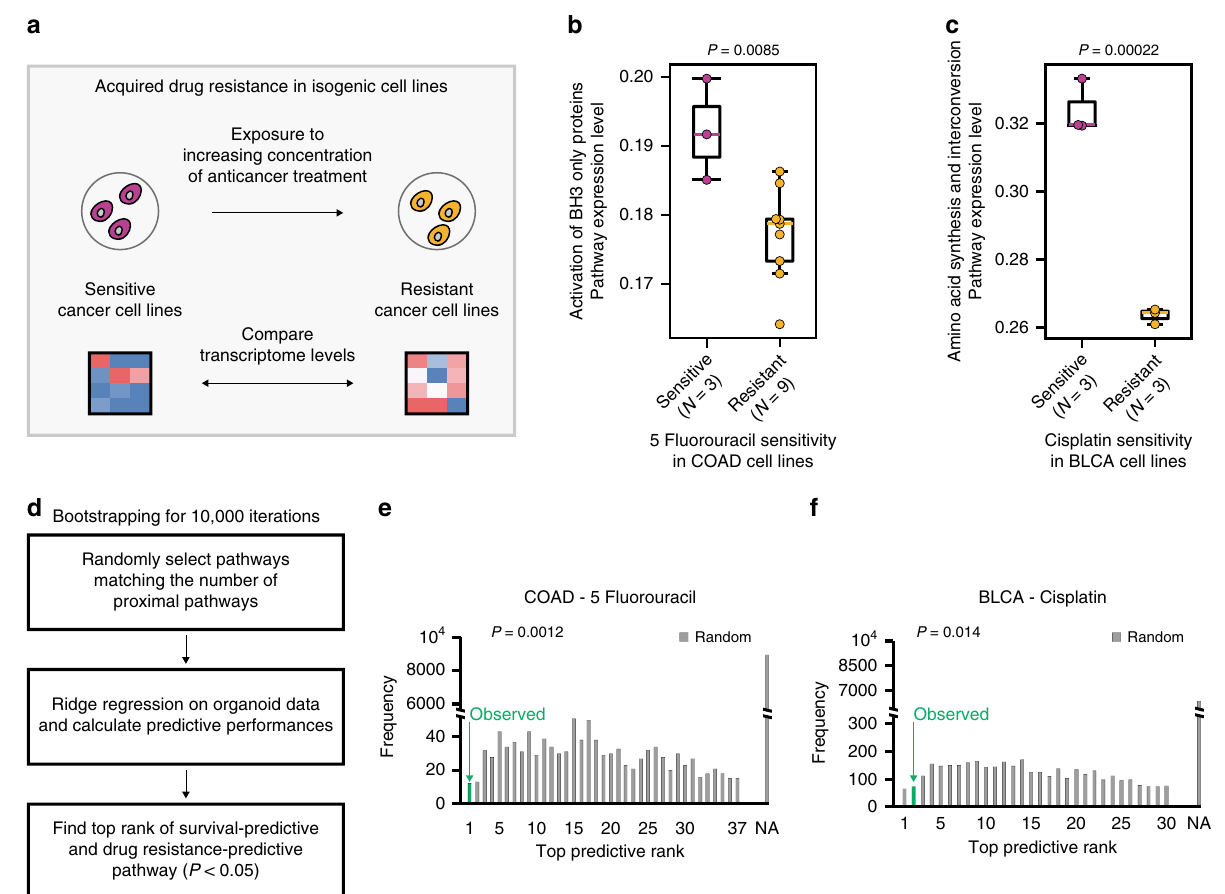
Fig. 4 Validation of drug-response biomarkers in independent datasets. a Overall scheme of the analysis. Isogenic drug-sensitive and -resistant cell lines were used for the analysis. Transcriptomic differences between the drug-sensitive and -resistant cell lines were investigated. b Differences in the expression levels of the “ activation of BH3-only proteins ” pathway between 5- fl uorouracil-sensitive ( n = 3) and -resistant ( n = 9) colorectal cancer cell lines. Single sample GSEA (ssGSEA) was performed to calculate pathway expression levels. A two-sample, two-tailed Student ’ s t-test was performed to measure statistical signi fi cance. Boxplot displays median value, interquartile range (IQR) as bounds of box and whiskers extending to upper/lower quartile ± IQR × 1.5. c Differences in the expression levels of the “ amino acid synthesis and interconversion ” pathway in cisplatin-sensitive ( n = 3) and -resistant ( n = 3) cell lines. A two-sample, two-tailed Student ’ s t-test was performed to measure statistical signi fi cance. Boxplot displays median value, IQR as bounds of box and whiskers extending to upper/lower quartile ± IQR × 1.5. d Overall scheme of drug prediction from bootstrapping analysis. e , f Statistical signi fi cance of biomarker rank for colorectal cancer after 5- fl uorouracil treatment ( e ) and bladder cancer after cisplatin treatment ( f ). Statistical signi fi cance was computed using empirical P -value, which was calculated by the frequency of iterations with the top predictive ranks that were equal to or higher than the observed ranks divided by the total number of iterations (10,000). Random bootstrapping results are shown in gray. The observed rank from using proximal pathways to train ridge regression is displayed in green. If no pathway was predictive of survival for the random pathway sets, NA (not available) was provided. COAD, colorectal cancer; BLCA, bladder